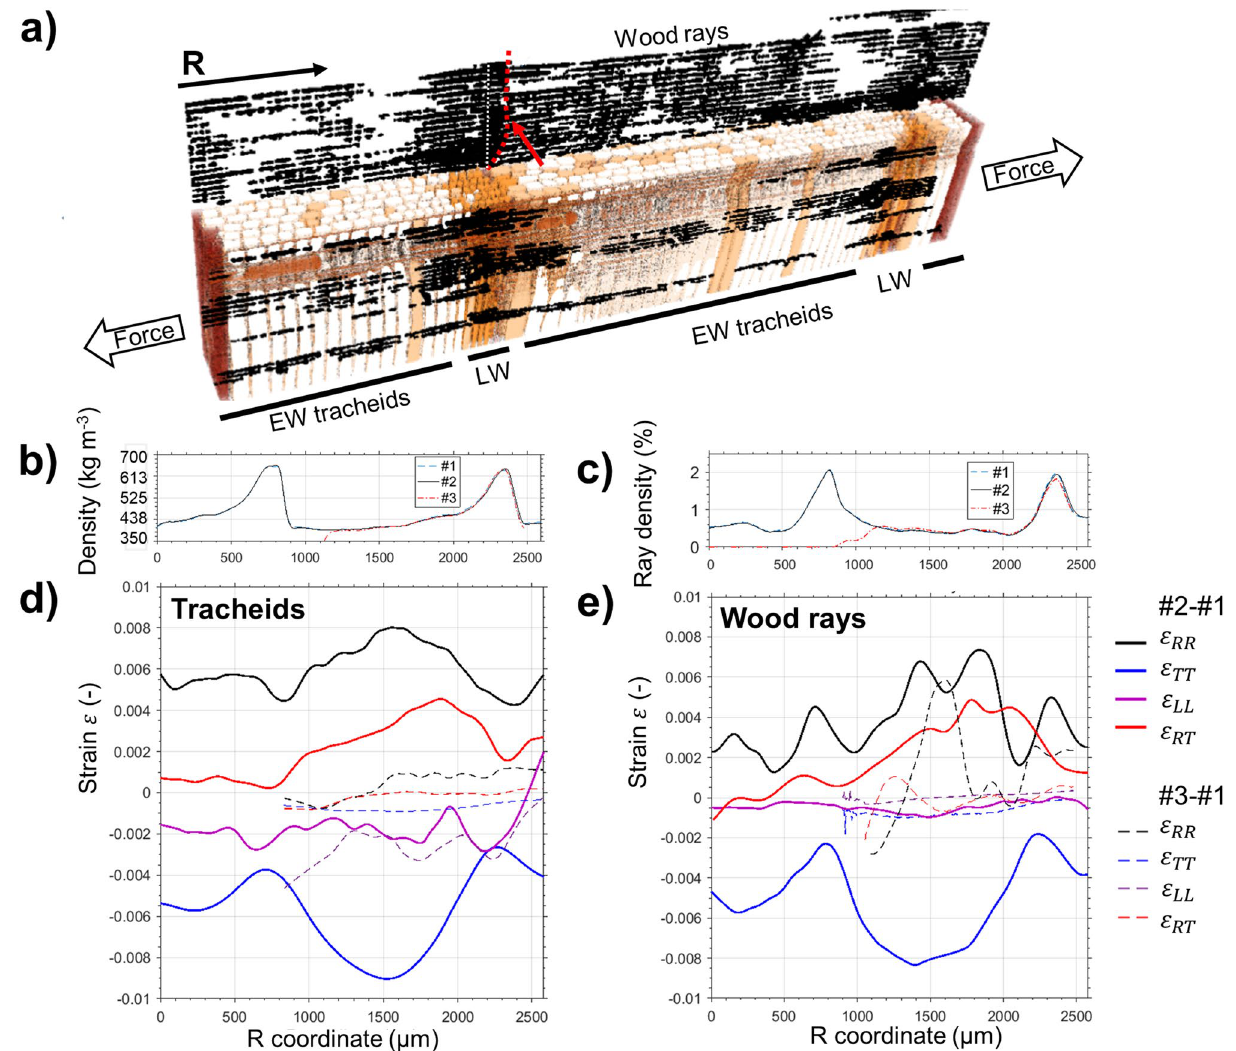
Figure 4. ICT for radial tension experiment (R-specimen). ( a ) Segmentation of tracheids and wood rays in reference state #1. ( b ) Tracheid density profile along a full growth ring. ( c ) Wood ray density profile. ( d ) Average strains calculated from tracheids in function of radial coordinate R. ( e ) Strains calculated from wood rays. For both ( c ) and ( d ), the elastic state #2 shows a heterogenous strain distribution along the growth ring, which is released upon fracture #3. The fracture line occurs at R = 1200 μm, after the first LW/EW transition, and is marked with a dashed red line in ( a ). Wood rays and tracheids follow similar strain patterns, indicating composite